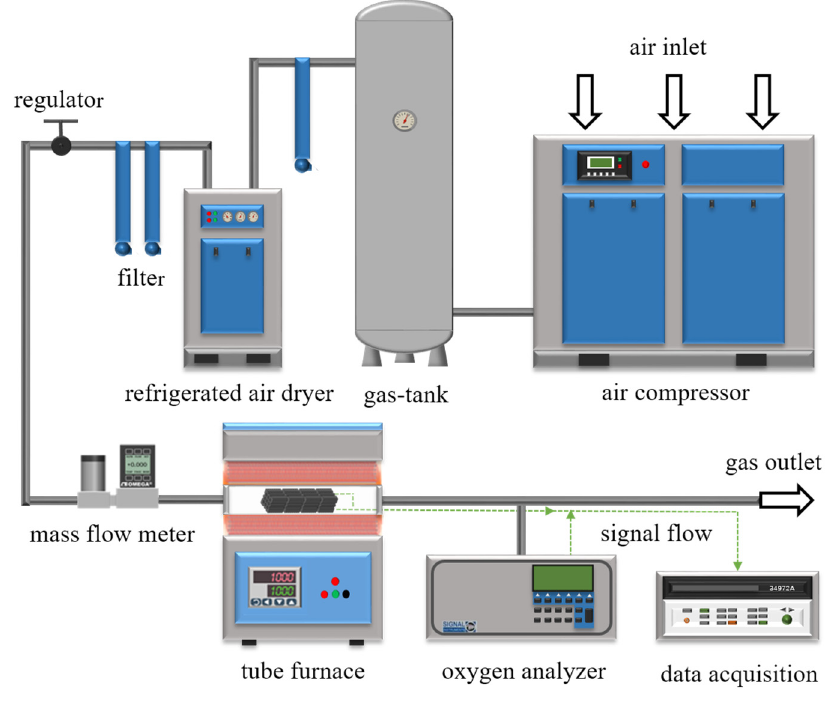
Figure 2. Honeycomb-structured-body charging/discharging test platform.